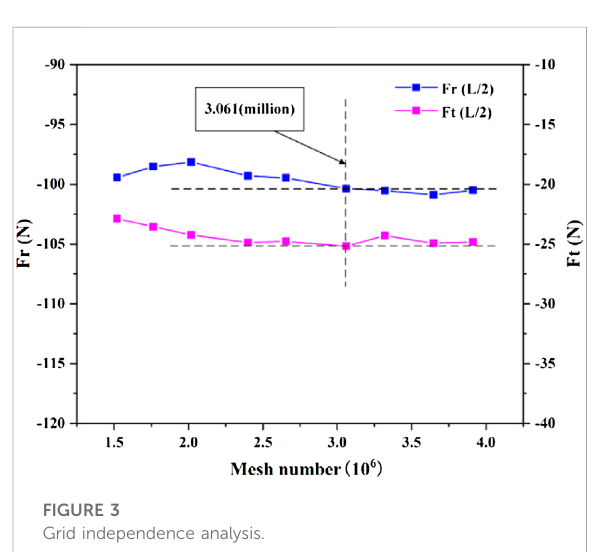
FIGURE 3 Grid independence